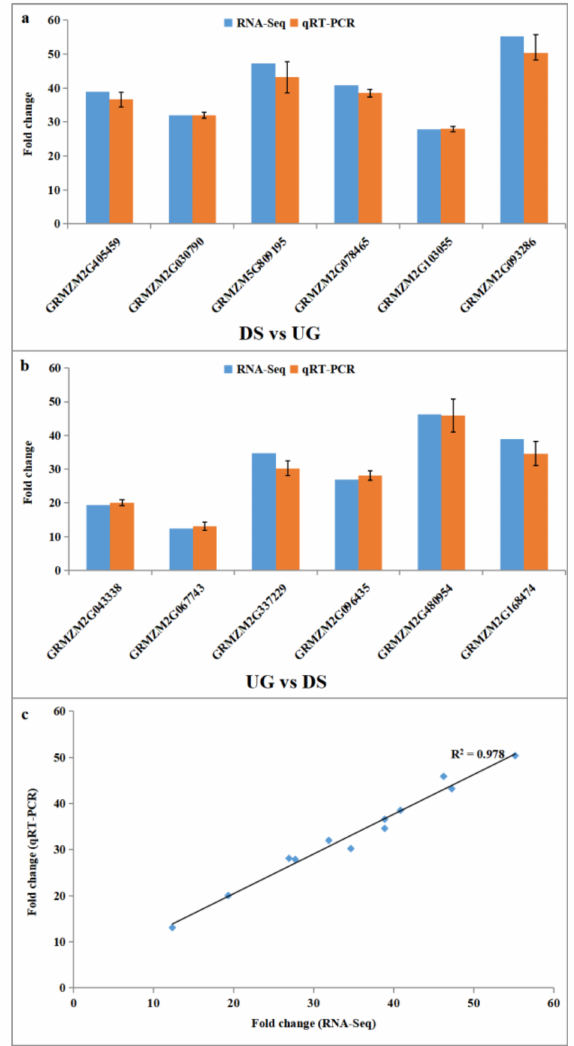
Figure 6. Real-time quantitative PCR (qRT-PCR) validation of RNA-Seq results. ( a , b ) Expression of six upregulated DEGs and six downregulated DEGs validated by qRT-PCR and compared with their expression obtained from RNA-Seq. ( c ) Pearson correlation analysis of gene-expression ratios obtained from qRT-PCR and RNA-Seq data. Error bars indicate standard error of the